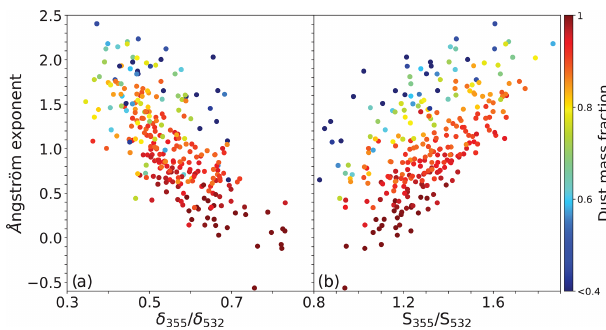
Figure 9. Correlation between the extinction-related Ångström ex- ponent and (a) the ratio of depolarization ratios and (b) the ratio of lidar ratios at 355 and 532nm wavelength. The values are color- coded as a function of dust mass fraction.